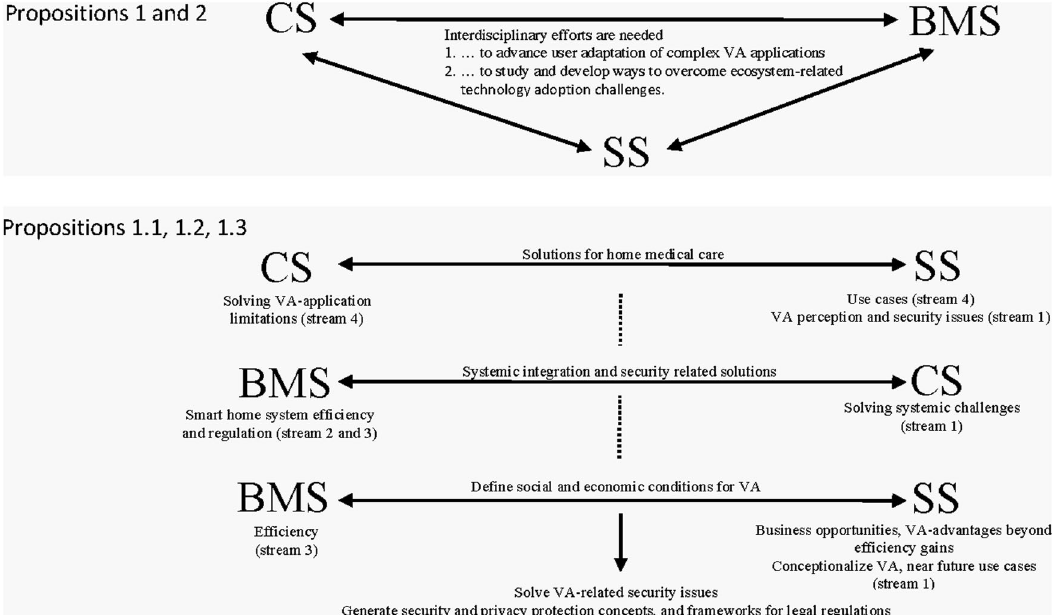
Fig. 6 Conceptual framework for future research. The framework highlights the focus of propositions 1 and 2 and re fl ecting propositions 1.1, 1,2, and